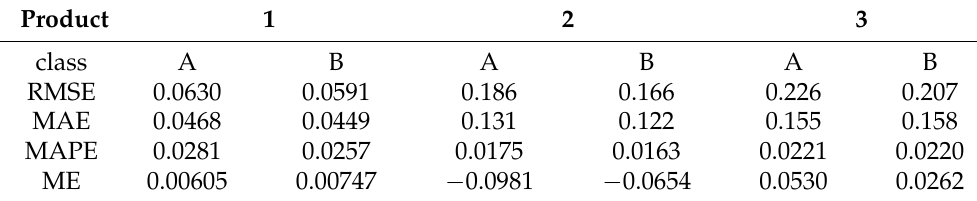
Table A3. Performance of the fine-tuned univariate deep learning models on the test